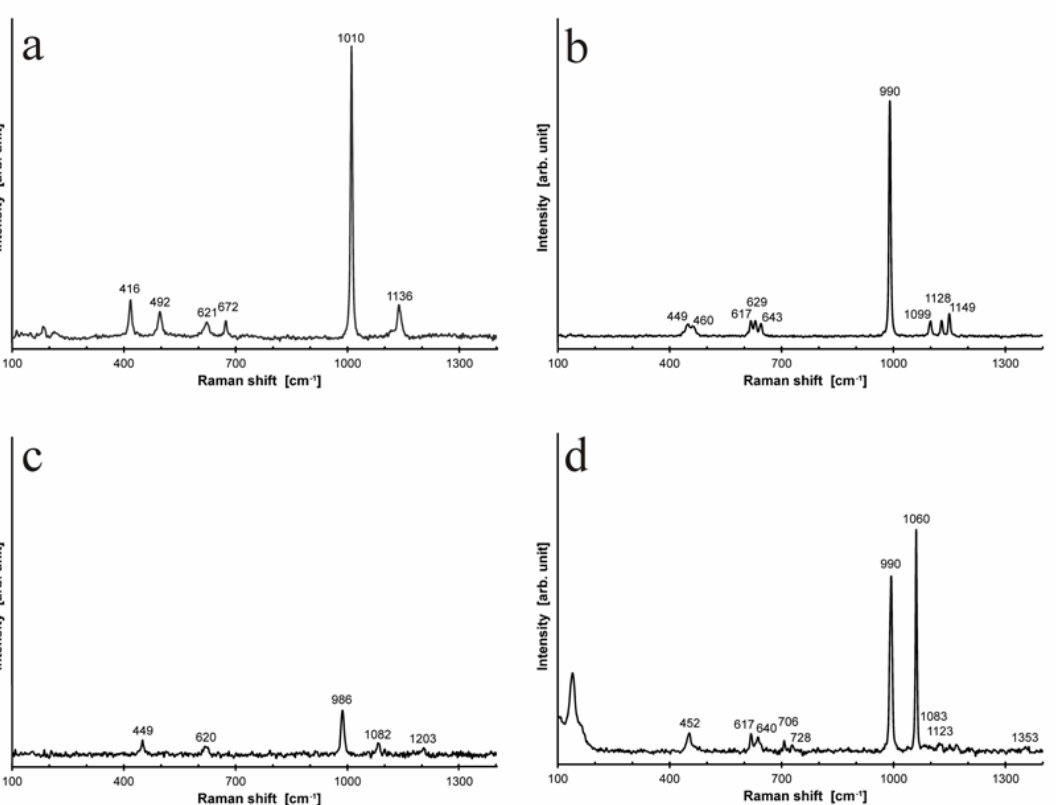
Figure 12. Representative, characteristic Raman spectra of the secondary salts: gypsum from the cement mortar crust ( a ) and efflorescence at the border between the subwall limestone blocks and cement mortar: thenardite ( b ); aphthitalite ( c ); darapskite ( d ).